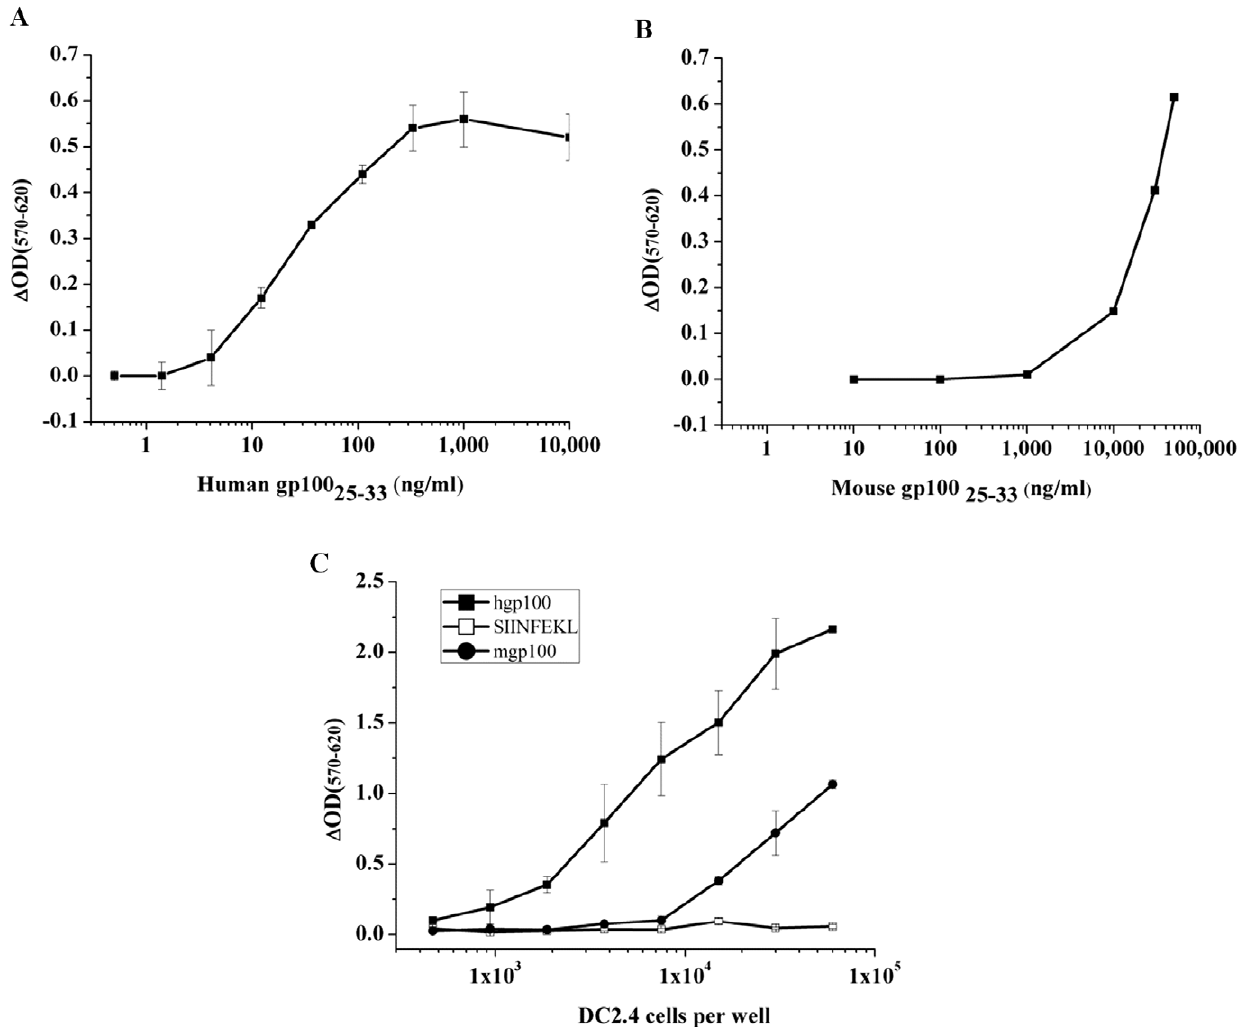
Figure 1. BUSA14 cells are efficiently activated by mouse and human gp100 25–33 peptides. DC2.4 cells were loaded with hgp100 25–33 at doses ranging from 0.5 to 10000 ng/ml ( A ) or mgp100 25–33 (10 to 50000 ng/ml)( B ). Then co-cultured with BUSA14 for 12 hours. Cells were then lysed and b -Gal enzymatic activity was detected with CPRG. Representative results (1 of 3 experiments) are presented as D OD (sample OD-background OD) measured after 3 hours. C. Sixty thousand BUSA14 cells/well were incubated in triplicate overnight with serial dilutions of DC2.4 cells loaded with 50 m g/ml hgp100 25–33 or mgp100 25–33 . SIINFEKL loaded DC2.4 cells were used as negative control. Assays were done as before and presented as D OD measured after 24